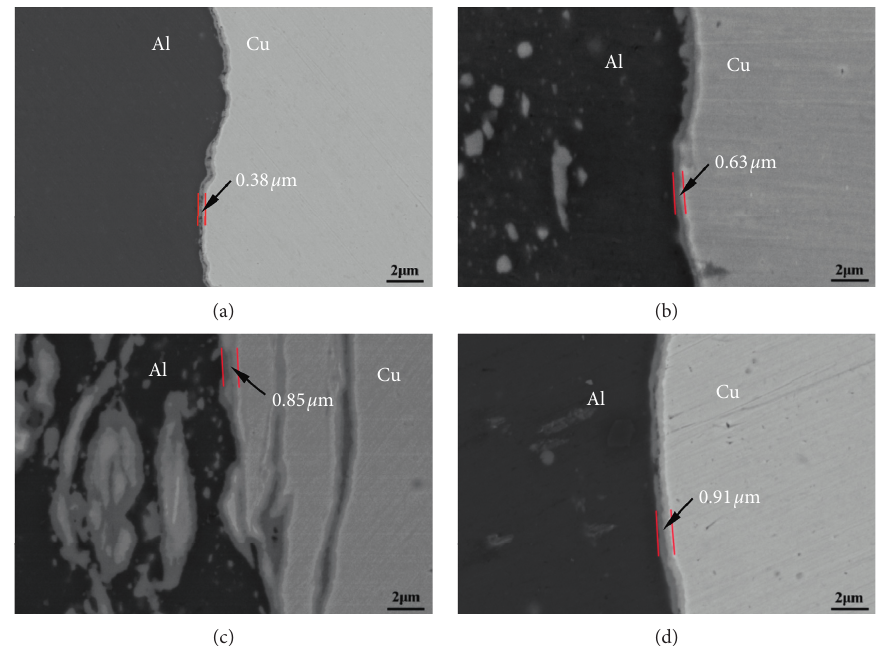
Figure 4: The SEM image of interface layer of the Al-Cu FSW joint produced by (a) 750rpm-0 ° , (b) 950rpm-0 ° , (c) 1180rpm-0 ° , and (d) 1500rpm-0 °